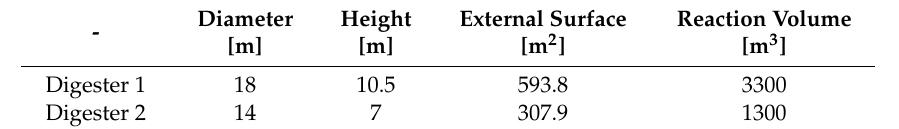
Table 1. The geometric characteristics of the digesters.